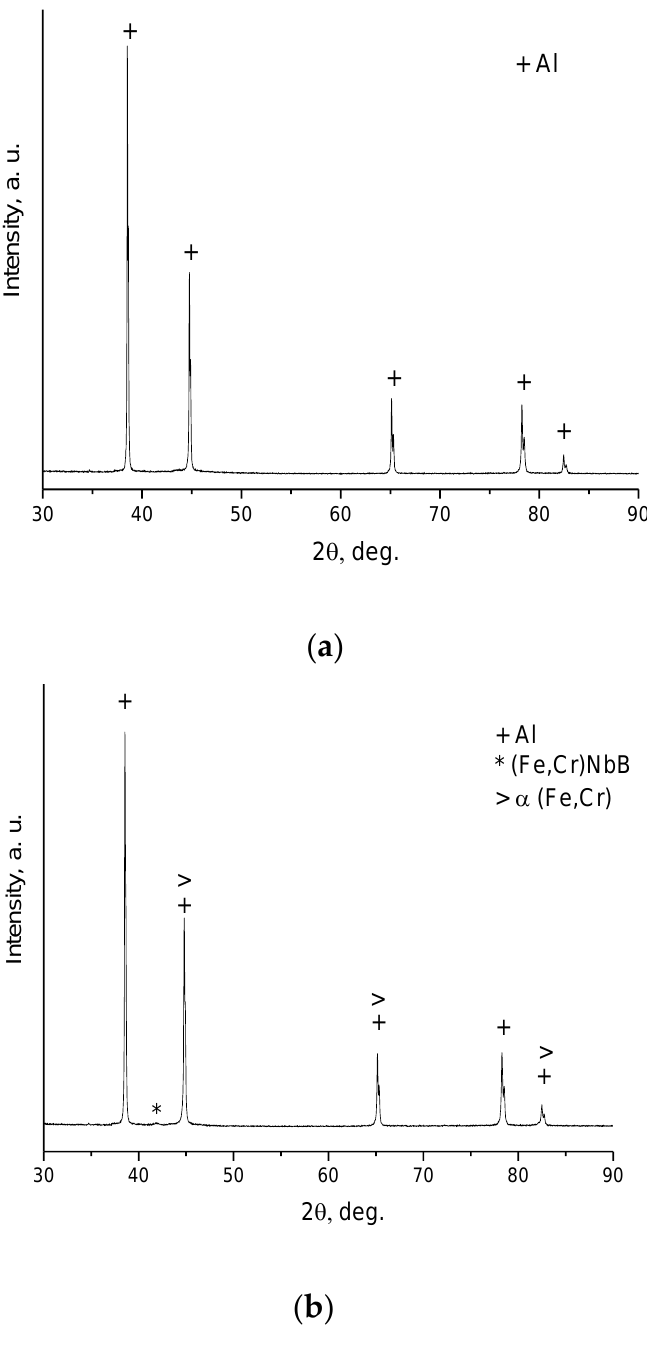
Figure 5. XRD patterns of the hot-pressed composites obtained from ( a ) Al (coarse) – glassy Fe 66 Cr 10 Nb 5 B 19 and ( b ) Al (coarse) – crystalline Fe 62 Cr 10 Nb 12 B 16 mixtures. Table 1. Relative density of the sintered composites. Relative Density, % Powder